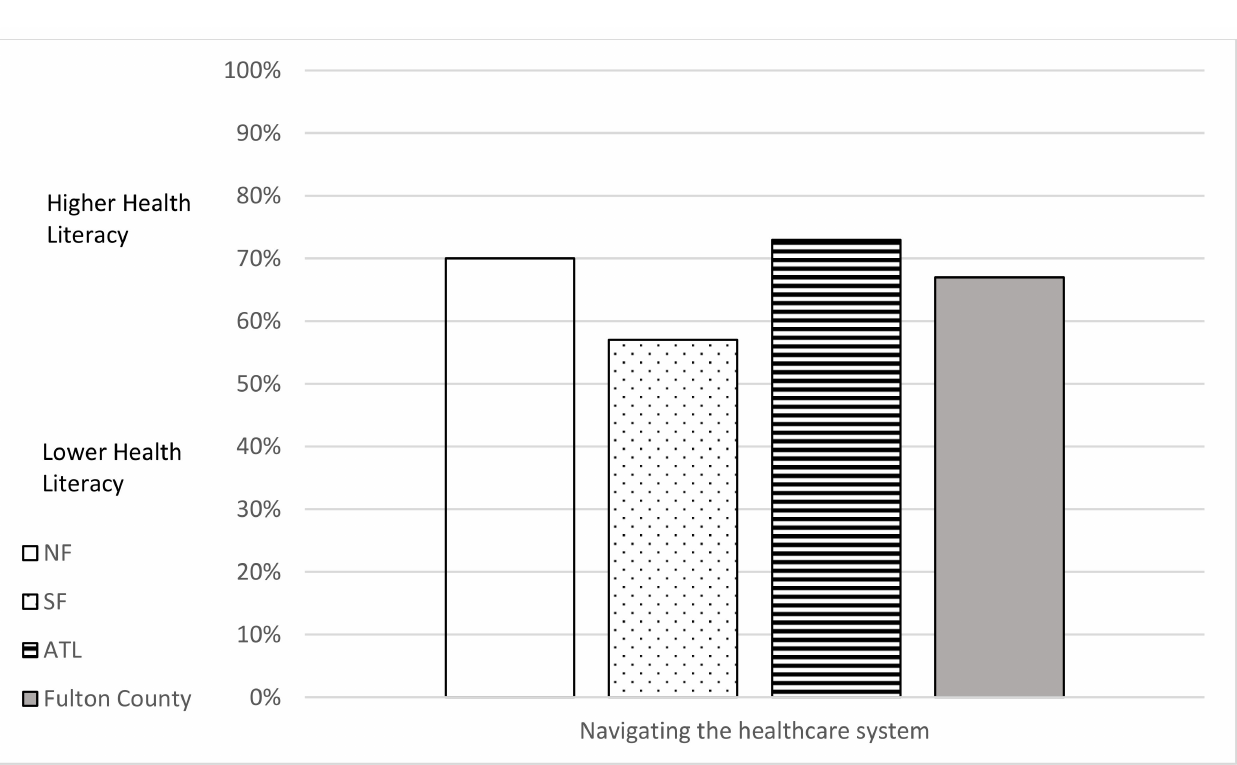
Figure 4. Organizational Health Literacy Scale (cut point 60%) by County Area: Navigating the Healthcare Systems. Based on Level of Difficulty (lower = cannot do/very difficult/quite difficult; higher = easy/quite easy).